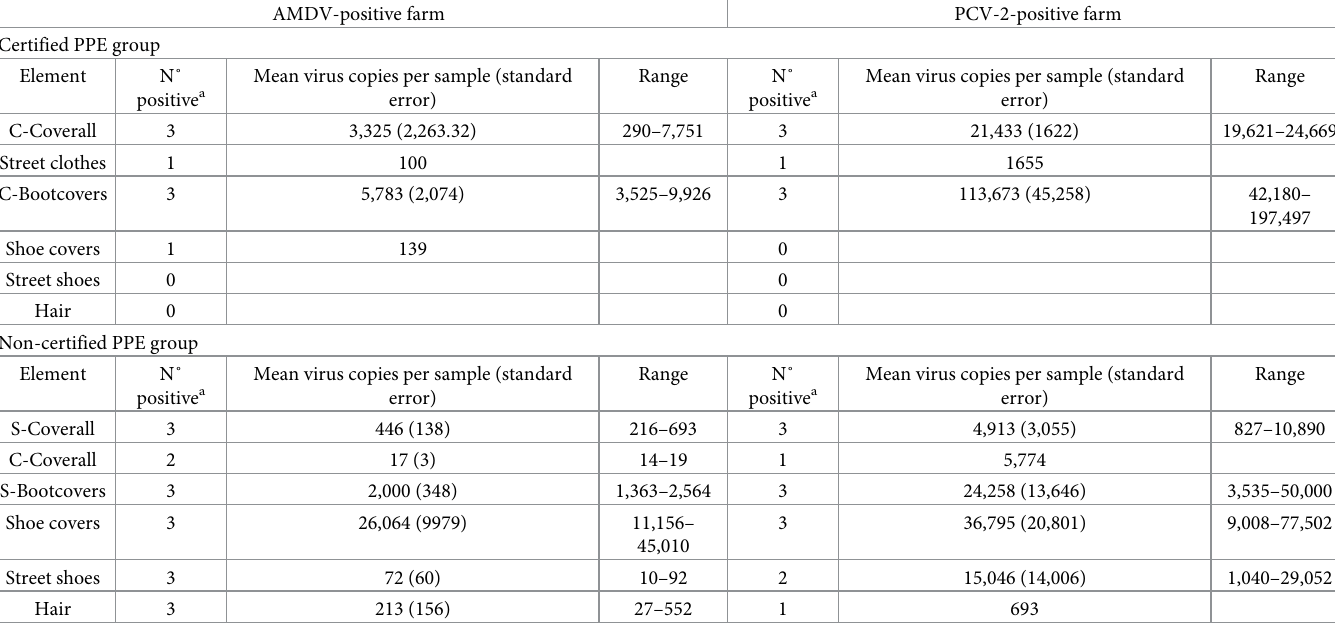
Table 2. Results of qPCR from personal protective equipments after the visit to positive farms to AMDV and